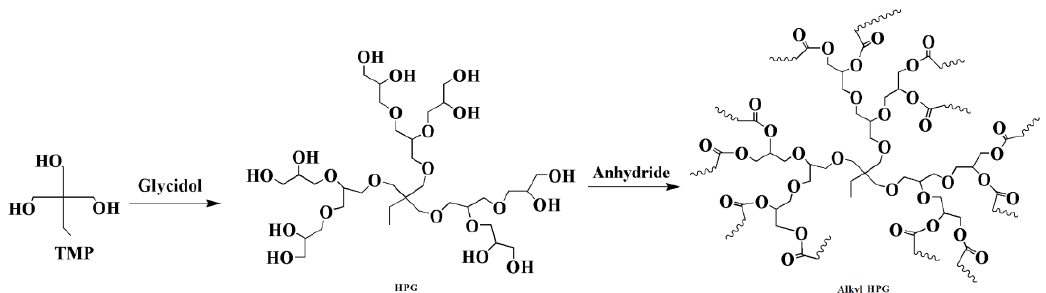
Figure 8. Synthesis of alkyl terminal hyperbranched polyglycerol (alkyl-HPG).